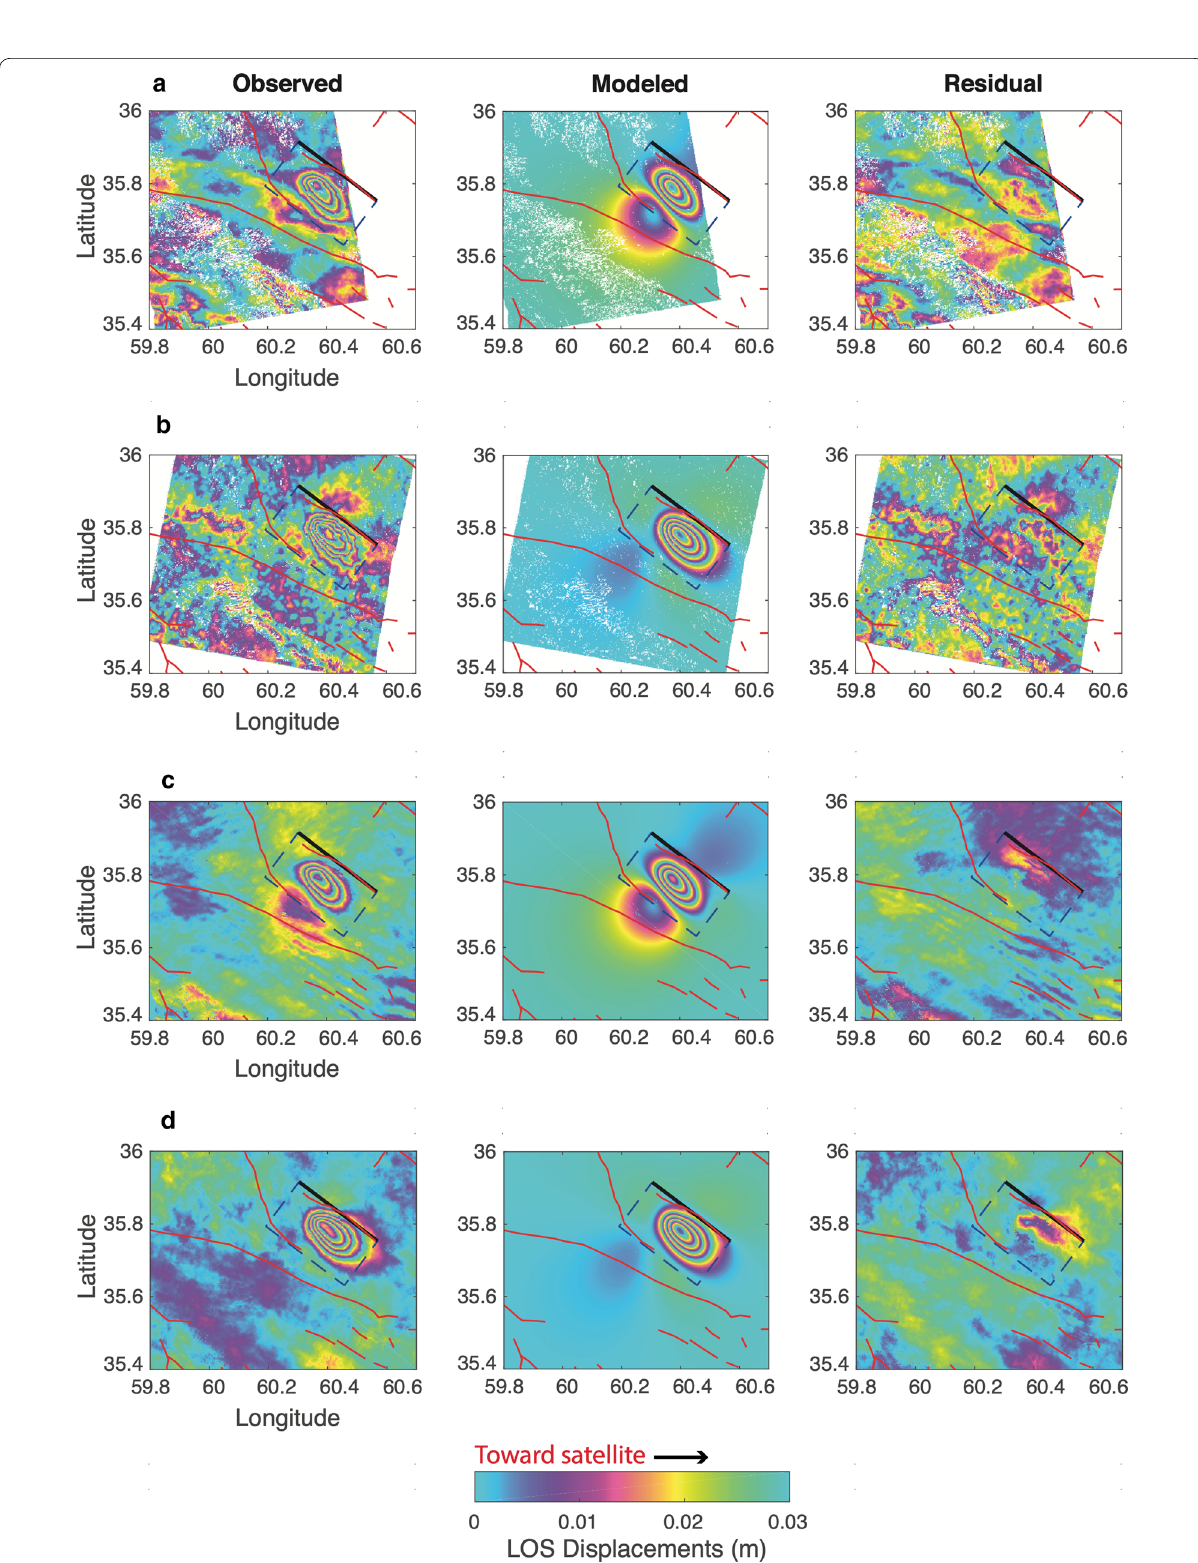
Fig. 10 Observed, modeled and residual interferograms for the SW-dipping fault model fixing strike to the mapped faults in the region. a , b ALOS-2 ascending and descending datasets, respectively. c , d Sentinel-1A ascending and descending datasets,